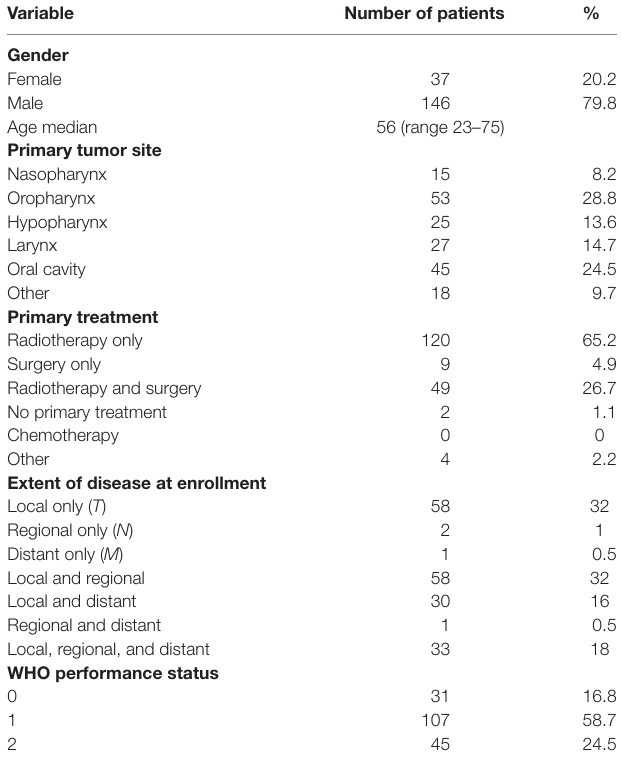
TaBlE 1 | Baseline characteristics of the